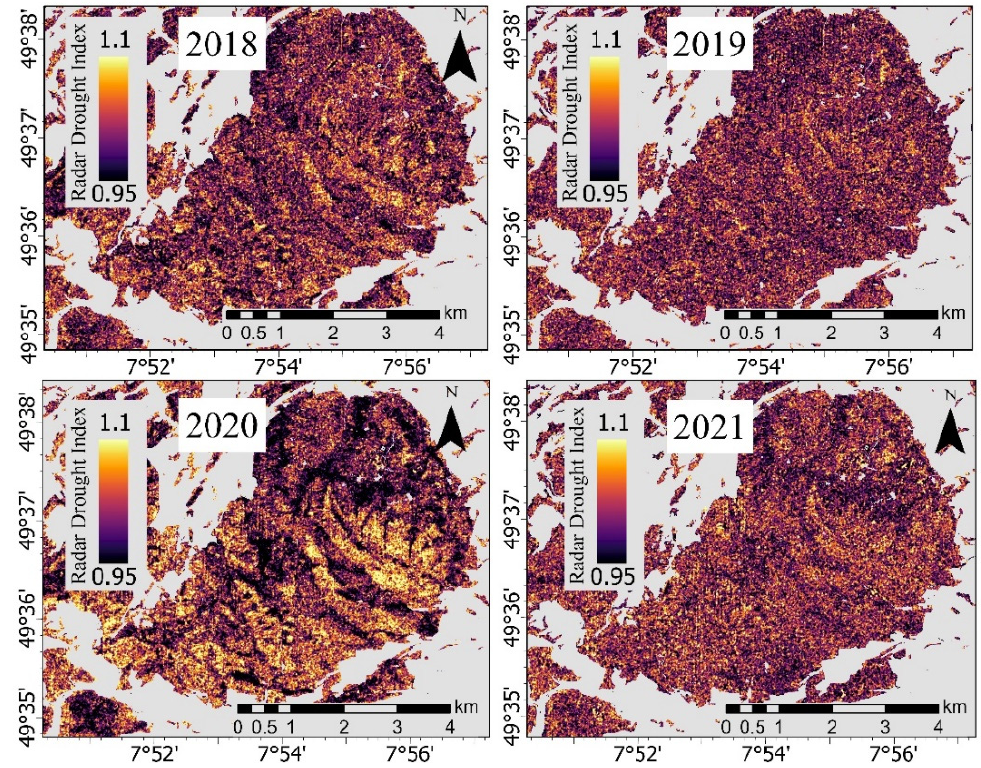
Figure 11. Spatially high-resolution maps of 2018, 2019, 2020 and 2021 for forest stands at the Donnersberg area.